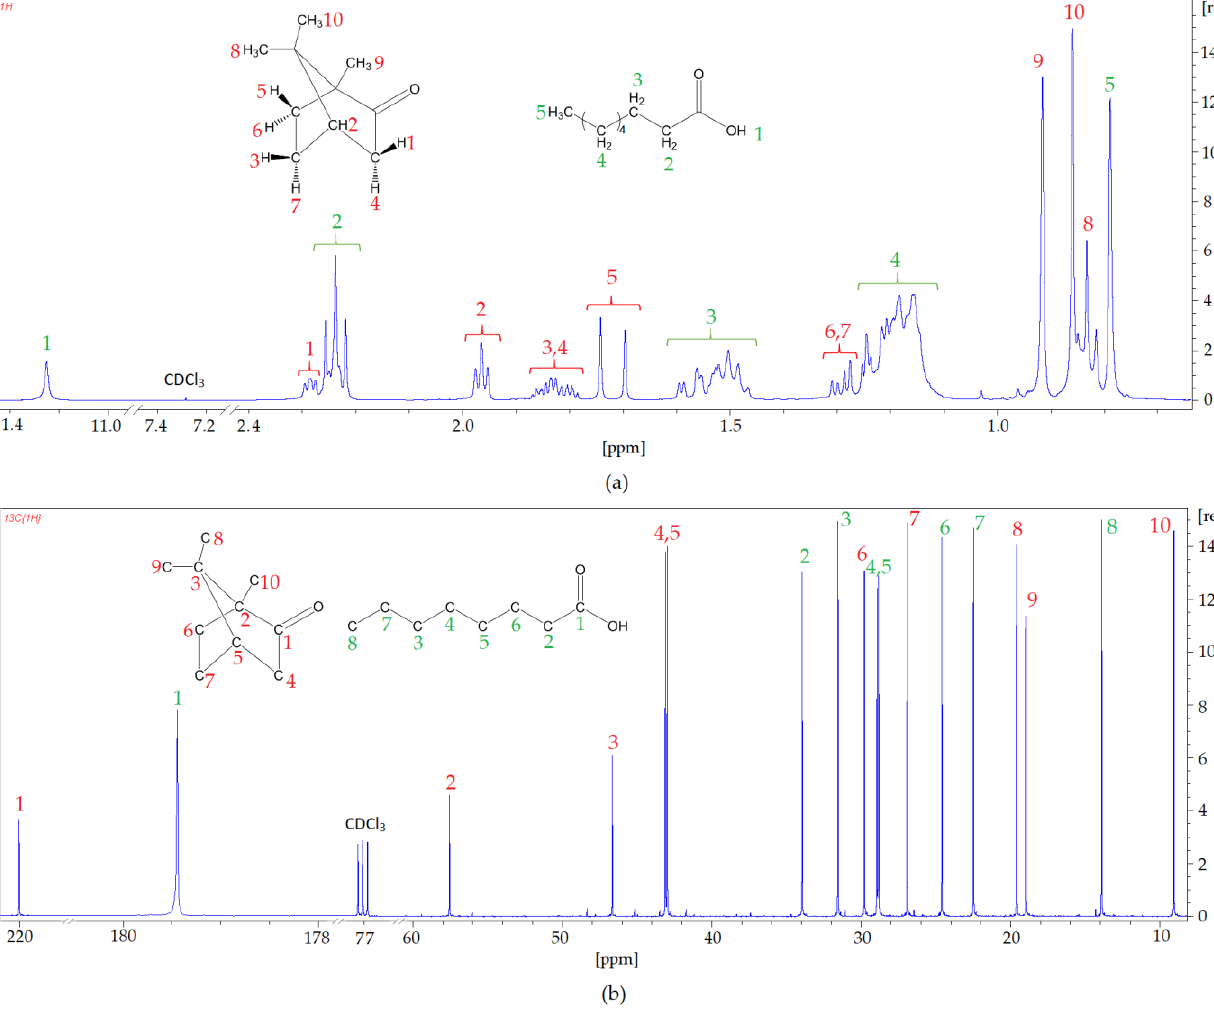
Figure 8. ( a ) 1 H NMR and ( b ) 13 C NMR spectra of Cam: OA (1:1).